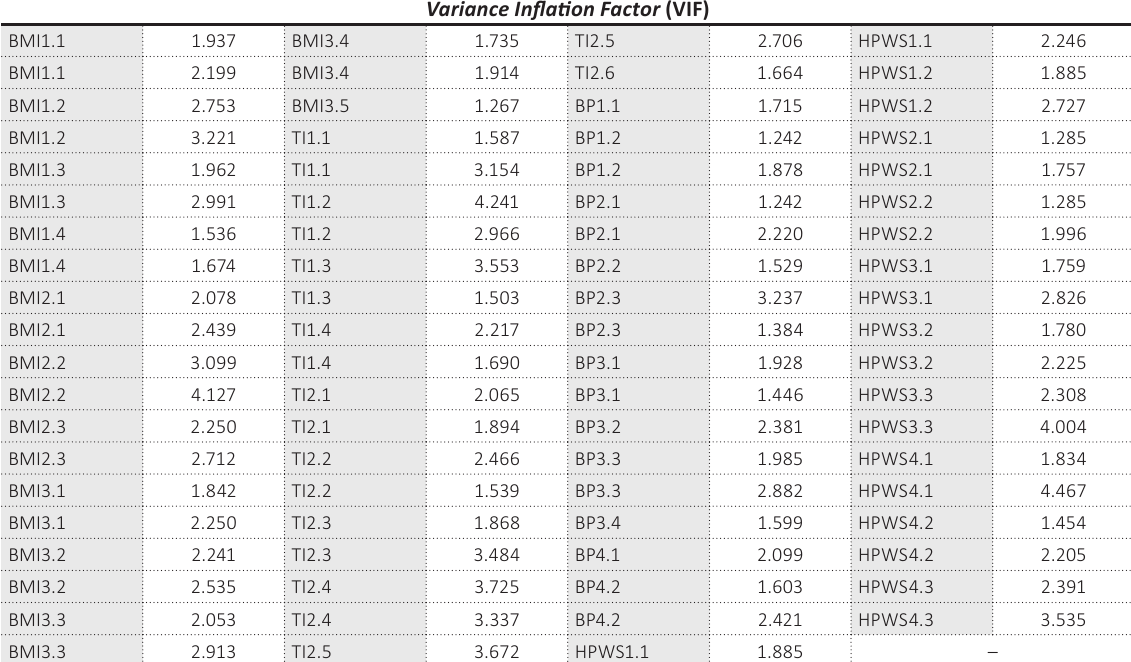
Table 5. Multicollinearity test results ( n = 70)